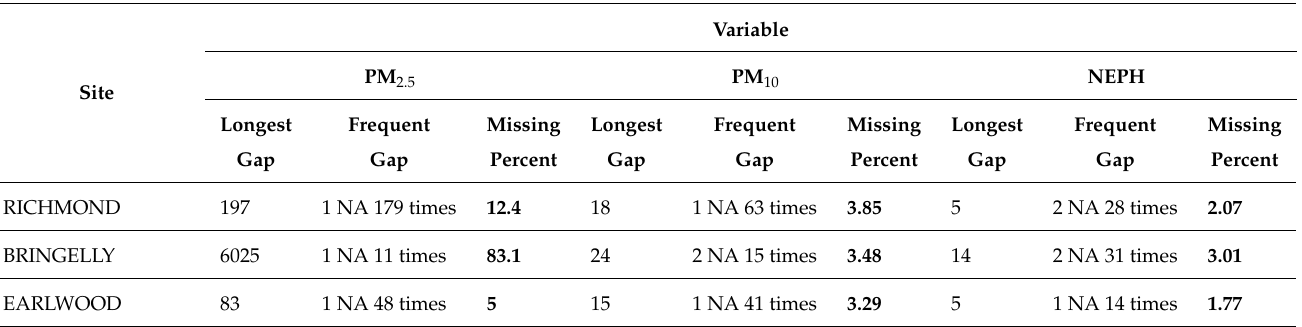
Table 2. Missing Statistics of daily PM 2.5 , PM 10 and NEPH observations at three monitoring sites in the Sydney region from 2000 to